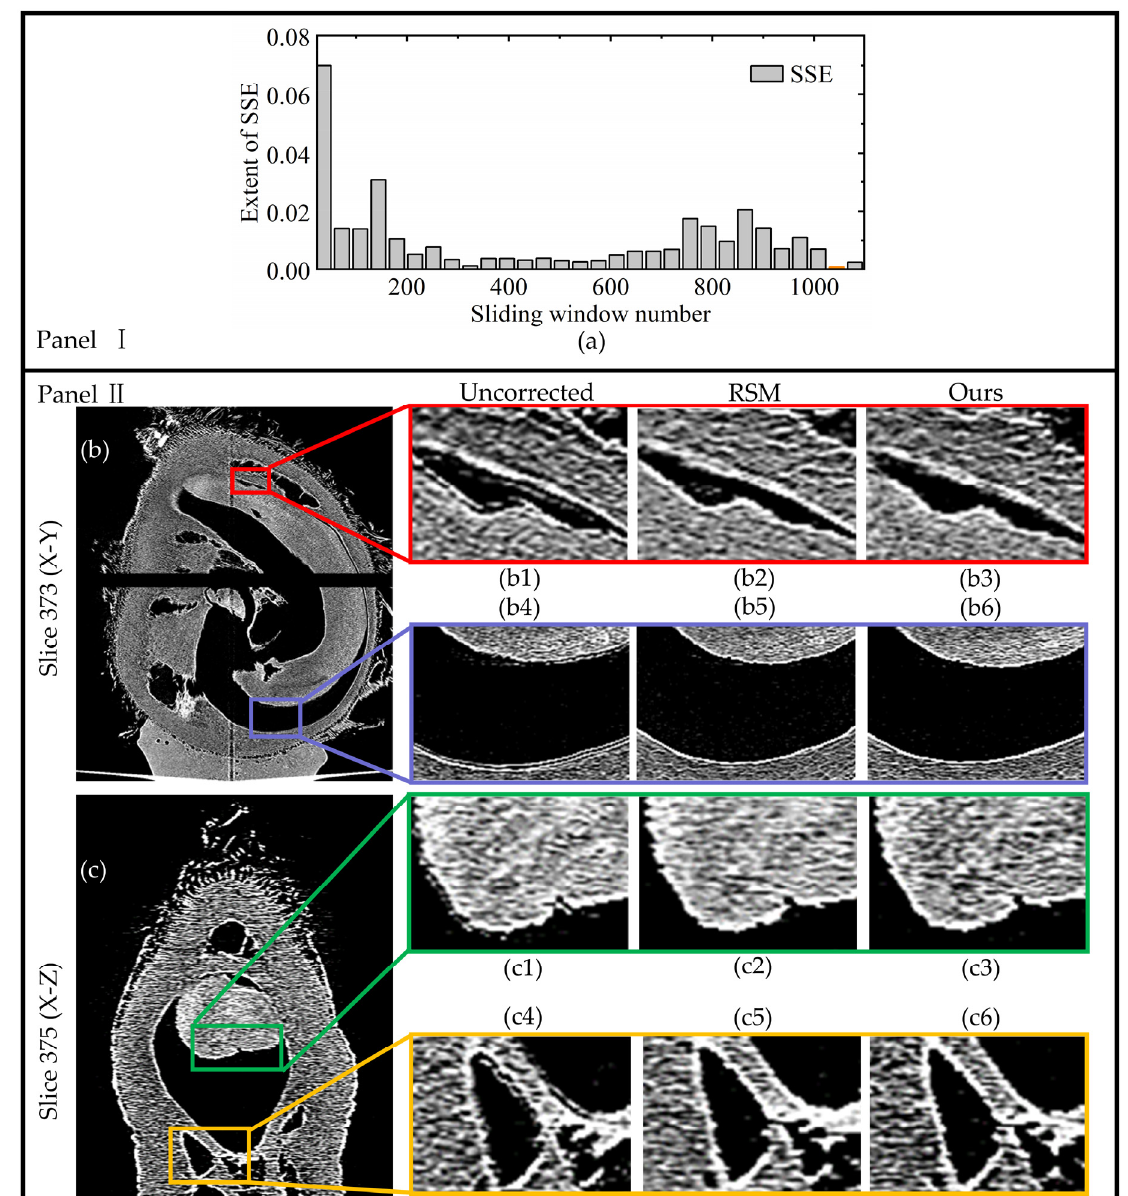
Figure 9. The experimental results of tomato seed scanning. Panel I: Process of determining the optimal interval and estimated drift. ( a ) SSE between the fitted trajectory and measured trajectory. The optimal projection interval is marked in yellow. Panel II: Reconstructed slices of tomato seed. ( b ) 373rd layer slice in the X-Y plane. ( b1 – b6 ) Local magnification of the box mark in ( b ). ( c ) 375th layer slice in the X-Z plane. The second column shows the partial enlarged image of the original reconstructed slice. ( c1 – c6 ) Local magnification of the box mark in ( c ). The third and fourth columns show the reconstructed slice corrected via the RSM and the proposed method, respectively. Table 5. A numerical analysis of the correction results (our method and RSM) in Figures 8 and 9.